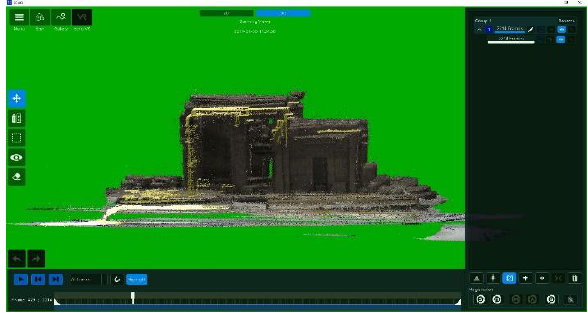
Figure 5. Misalignments between point cloud frames are visible after the acquisition, in yellow a single point cloud frame is highlighted